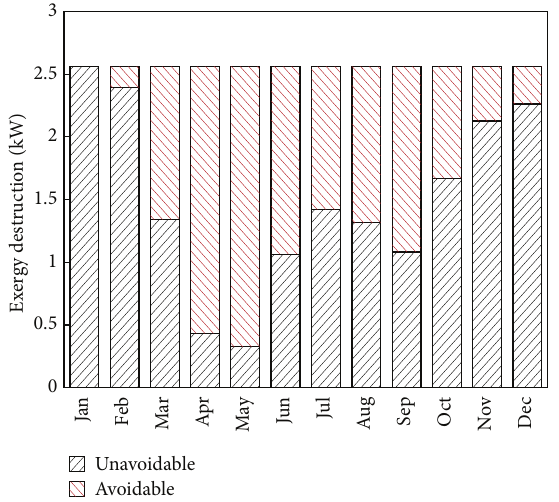
Figure 11: Exergy destruction rate of GSHP system during a